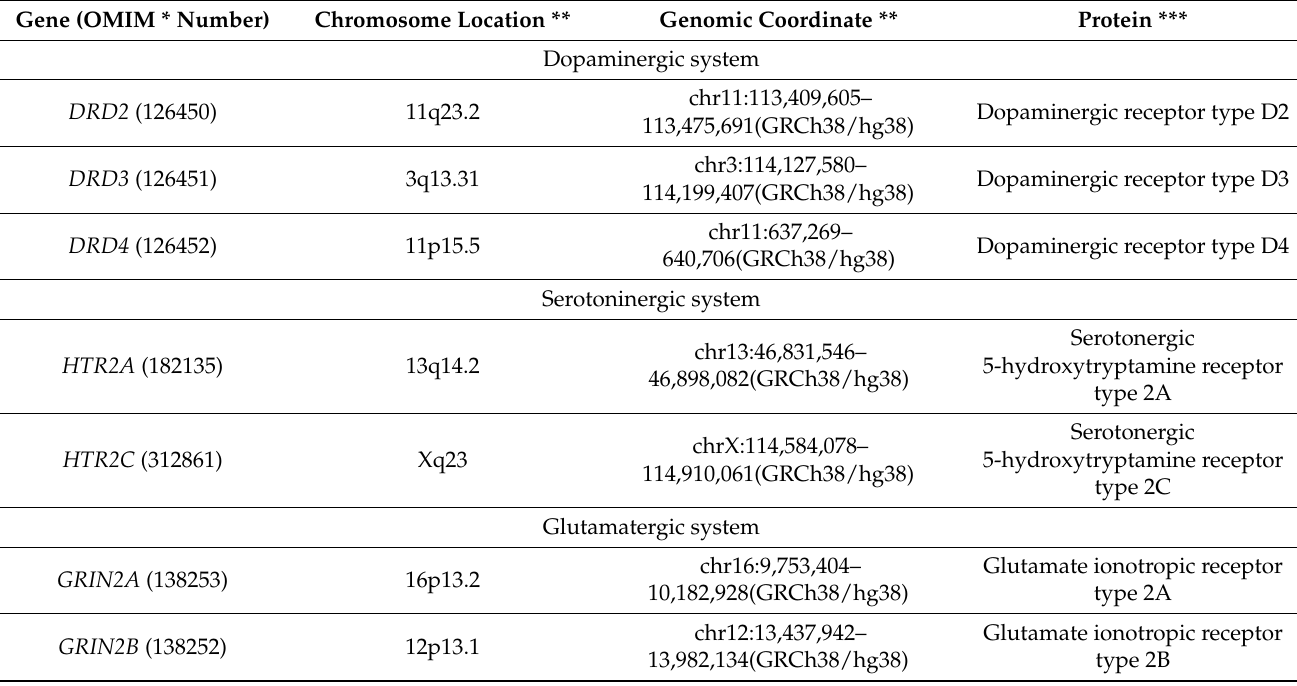
Table A8. Candidate genes encoding targets/receptors of